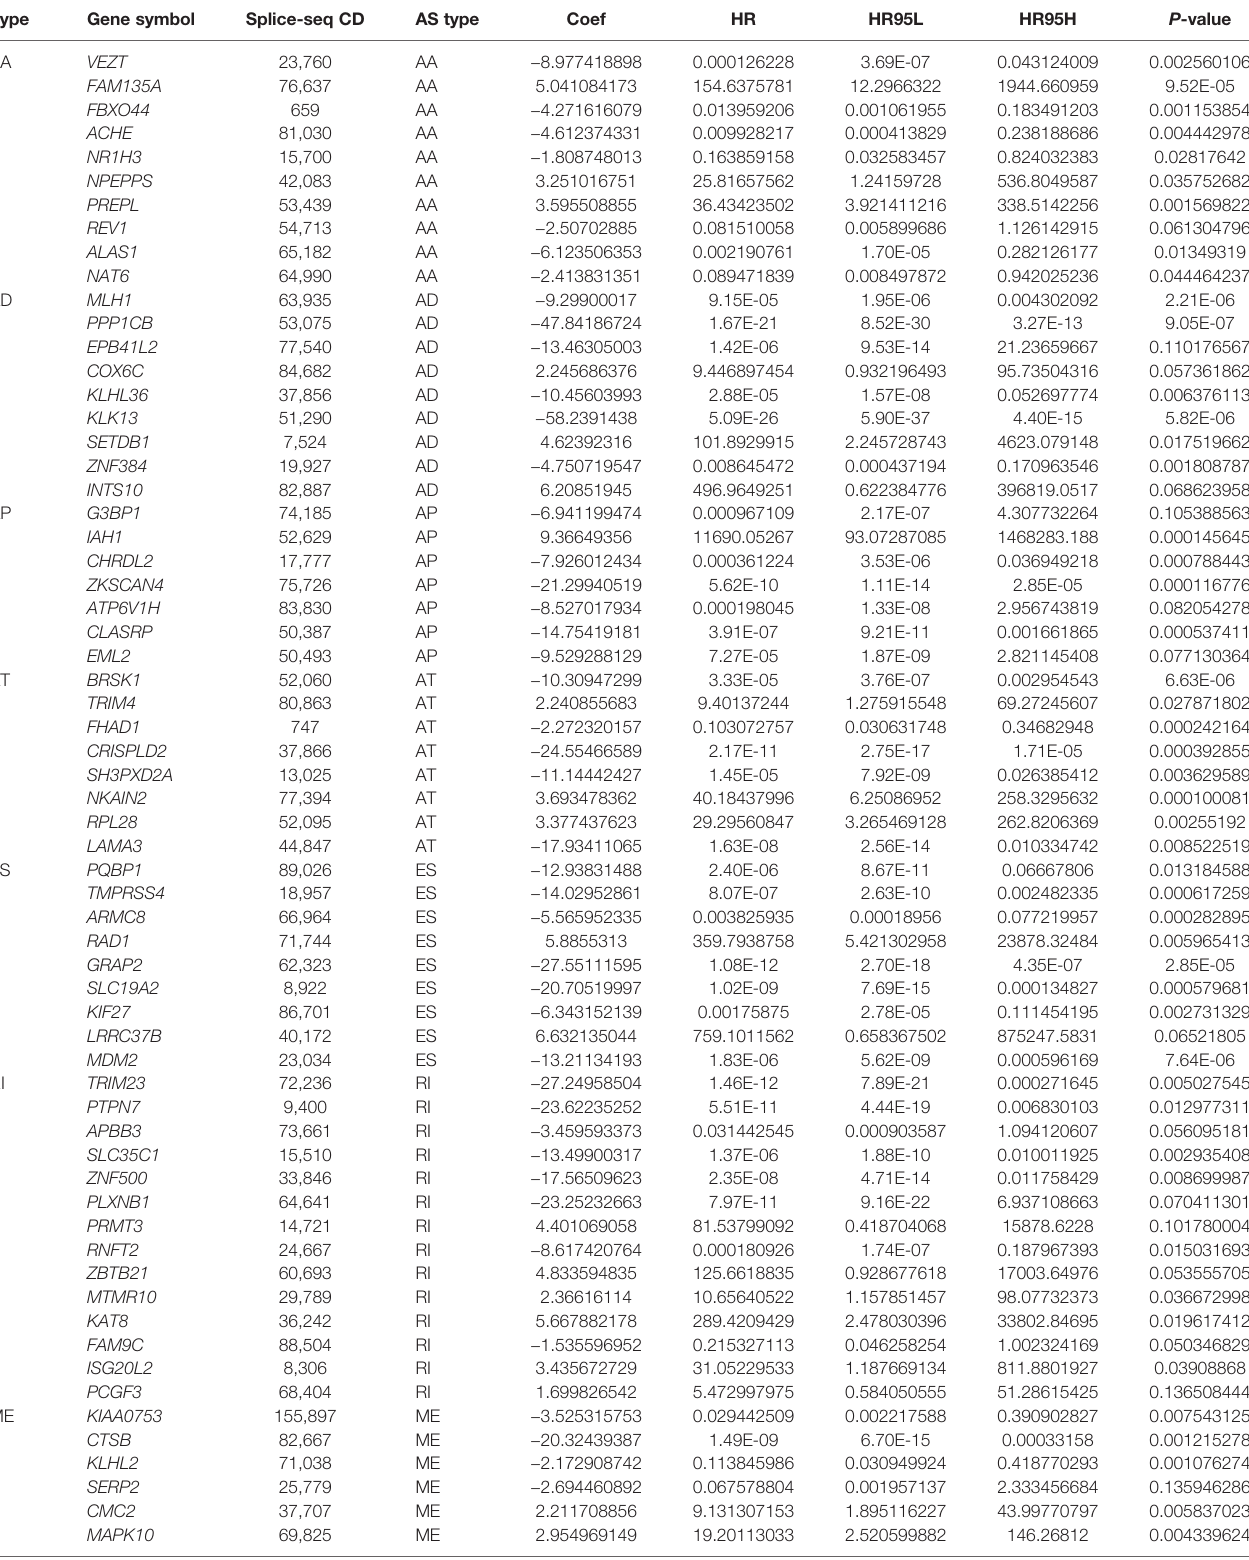
TABLE 2 | Multivariate Cox analysis of prognostic alternative splicing predicting overall